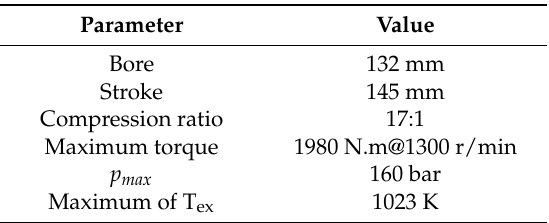
Table 2. Engine parameters.